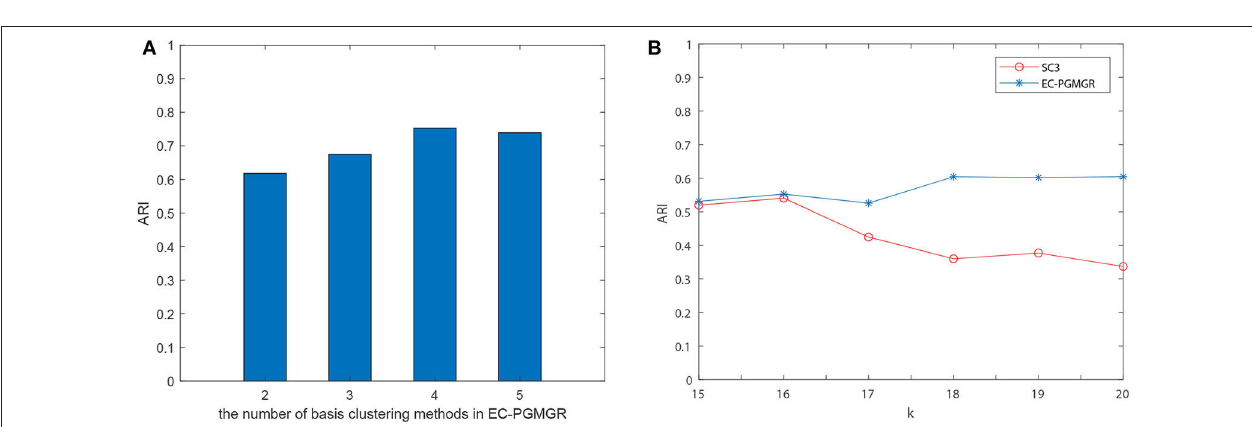
FIGURE 4 | (A) The performance of different combination of basis cluster on Baron-mouse1. (B) Assessing the robustness of EC-PGMGR when varying the number of clusters for SC3 results and holding the other three individual methods constant in Baron-human1. Different k will influence the results of SC3.